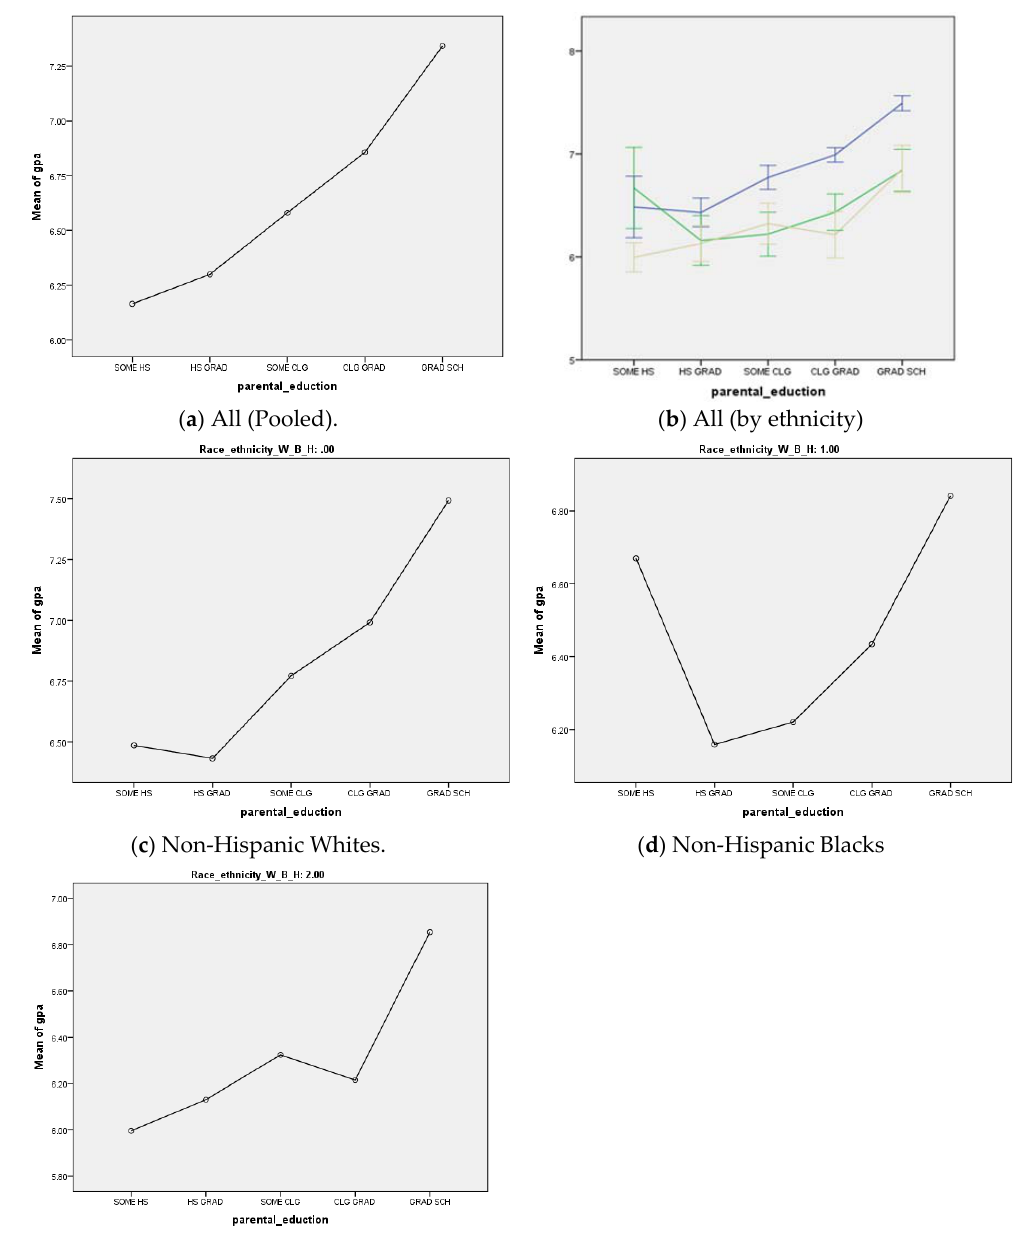
Figure 1. Association between parental education and school performance in Non ‐ Hispanic Whites (NHWs), Non ‐ Hispanic Blacks (NHBs), and Hispanic Whites (HWs). ( a ) All (Pooled); ( b ) All (by ethnicity); ( c ) Non ‐ Hispanic Whites; ( d ) non ‐ Hispanic Blacks; ( e ) Hispanic Whites.